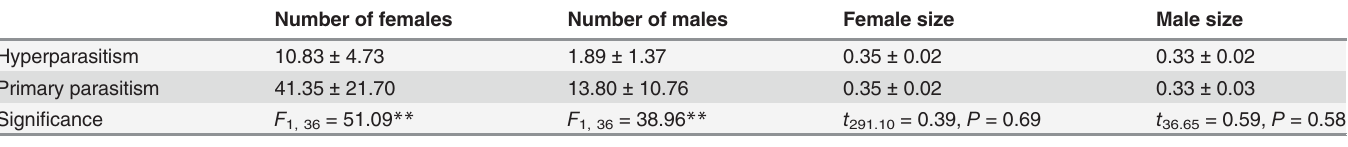
Table 4. Number and size of offspring of P . vindemmiae females from the conspecific hyperparasitism and primary